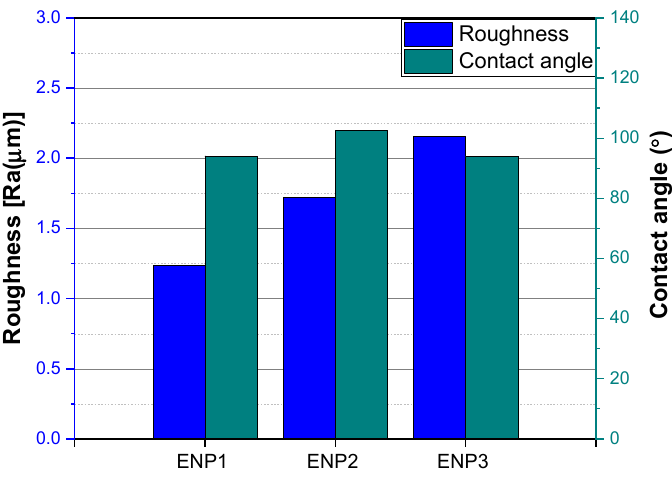
Figure 4. The water contact angle (WCA) and arithmetic average surface roughness parameter (Ra) of the deposited electroless ENP duplex coatings.